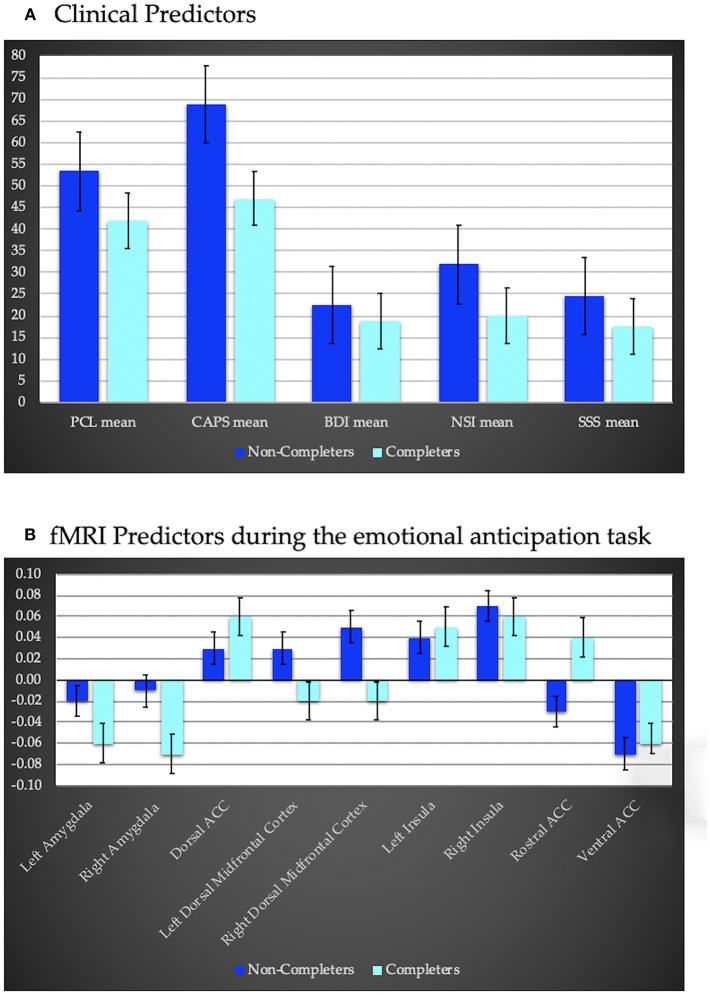
(A) clinical predictors of treatment completion including PTSD severity using the PTSD Symptom Checklist (PCL), and the Clinician Administered PTSD Scale (CAPS), depression severity assessed via the Beck Depression Inventory (BDI)—II, the Neurobehavioral Symptom Inventory (NSI) to assess sequelae of traumatic brain injury, and the Sensation Seeking Scale (SSS) to assess impulsivity. Completers exhibited less severe symptoms compared to non-completers. (B) fMRI predictors of treatment completion during an anticipation task (negative–positive affective trials). Regions of interest include bilateral amygdala, insula and dorsal midfrontal cortex, as well as dorsal, ventral, and rostral anterior cingulate cortex (ACC). Completers displayed hypoactivation within bilateral amygdala, and dorsal midfrontal cortex and hyperactivity within the rostral and dorsal ACC and left insula relative to non-completers.